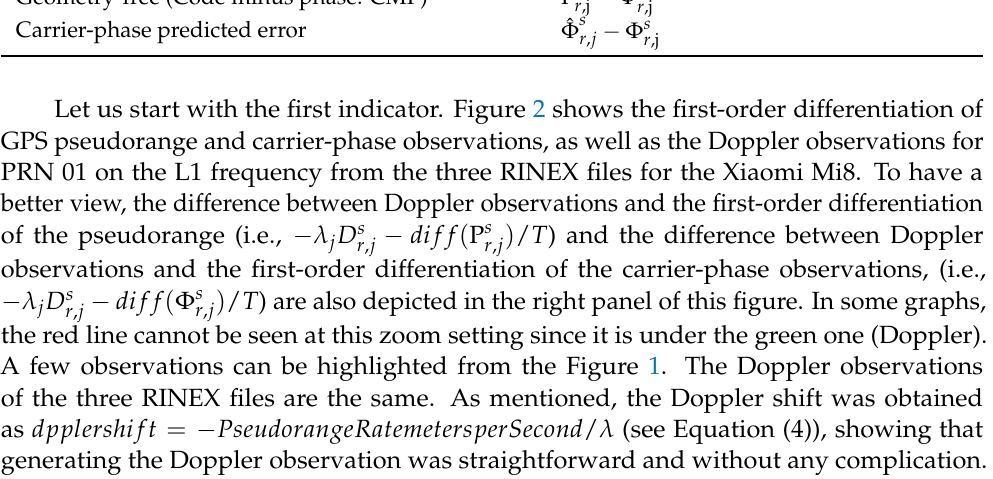
Table 3. Different indictors used to analyze raw GNSS observations. Indicator Formula First-order differentiation of pseudorange and phase versus Doppler observations Geometry-free (Code minus phase: CMP) Carrier-phase predicted